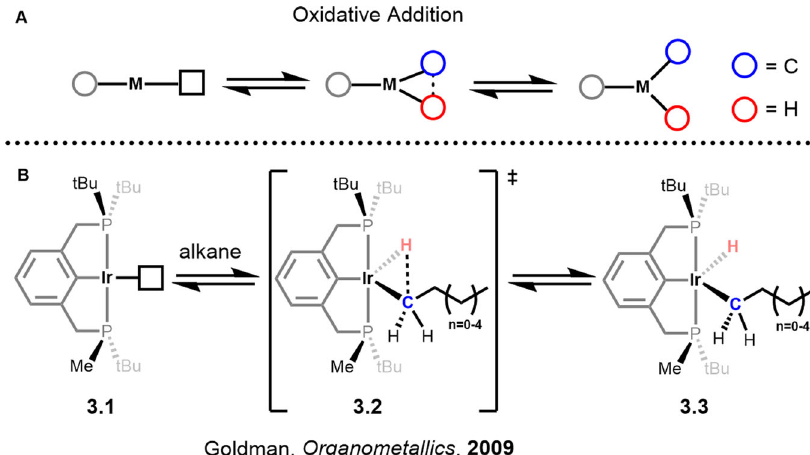
Fig. 5 Oxidative addition mechanism. A Simpli fi ed depiction of the oxidative addition mechanism. B Concerted oxidative addition of an alkane to an unsaturated Iridium(I) PCP